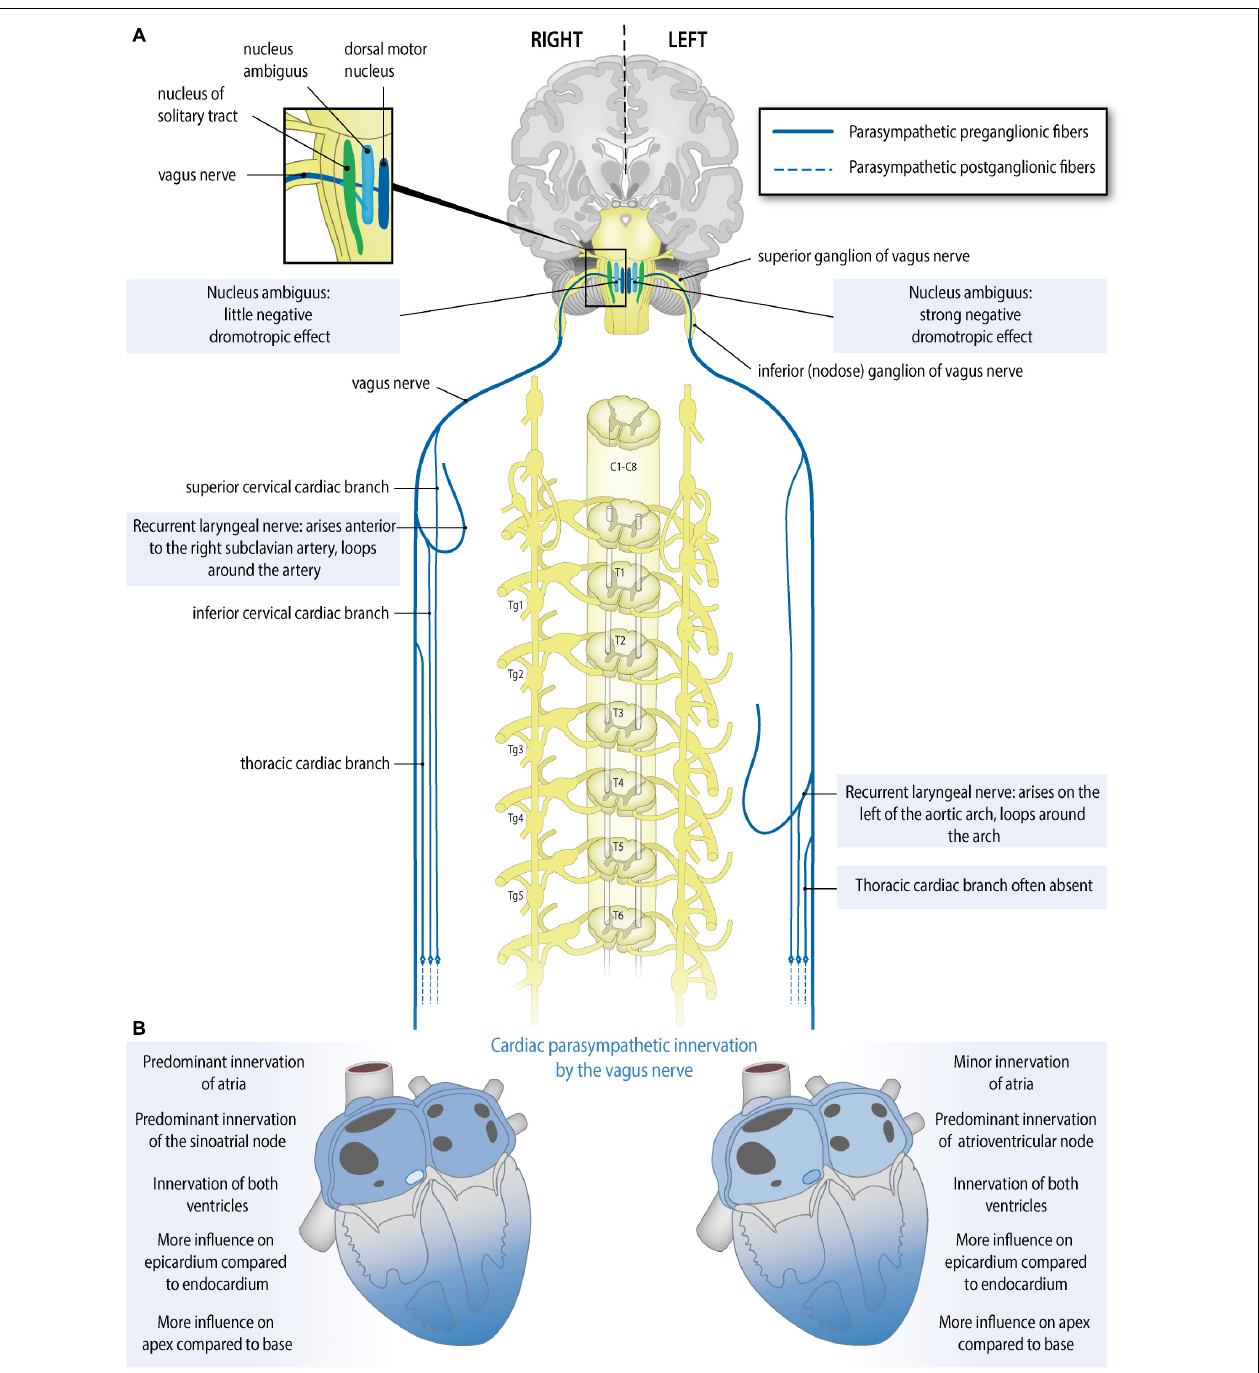
FIGURE 2 | Anatomy of the parasympathetic cardiac autonomic nervous system: asymmetry and regional differences. (A) Parasympathetic cardiac autonomic nervous system. Preganglionic cardiac parasympathetic axons (blue, solid lines) arise from neurons in either the nucleus ambiguus or dorsal vagal nucleus; they run in cardiac branches of the vagus nerve to synapse in cardiac plexuses and ganglia from where postganglionic fibers (blue, dotted lines) innervate the sinoatrial node (SAN), atrioventricular node (AVN), coronary arteries, and ventricular myocytes. Sided and regional differences in anatomy are indicated in the boxes. (B) Functional anatomy of the right and left vagal nerves. Sided and regional differences in function are indicated in the boxes. The right vagus nerve greatly slows heart rate, may influence the atria more than the left vagus nerve, slows atrioventricular conduction to some extent, influences the epicardium more strongly than the endocardium and influences the apex more strongly than the base. The left vagus nerve slows heart rate to some extent, may influence the atria less than the right vagus nerve, greatly slows atrioventricular conduction, influences the epicardium more strongly than the endocardium and influences the apex more strongly than the base.